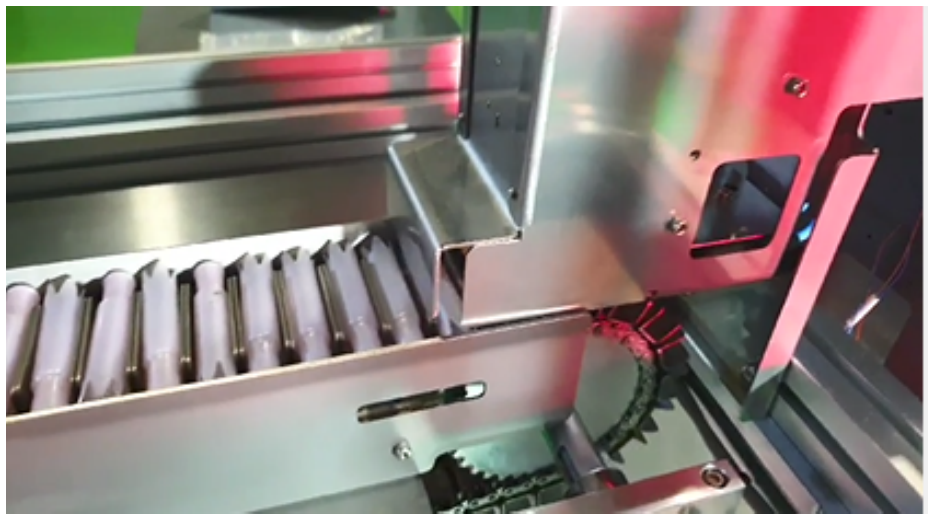
Figure 5. Product on